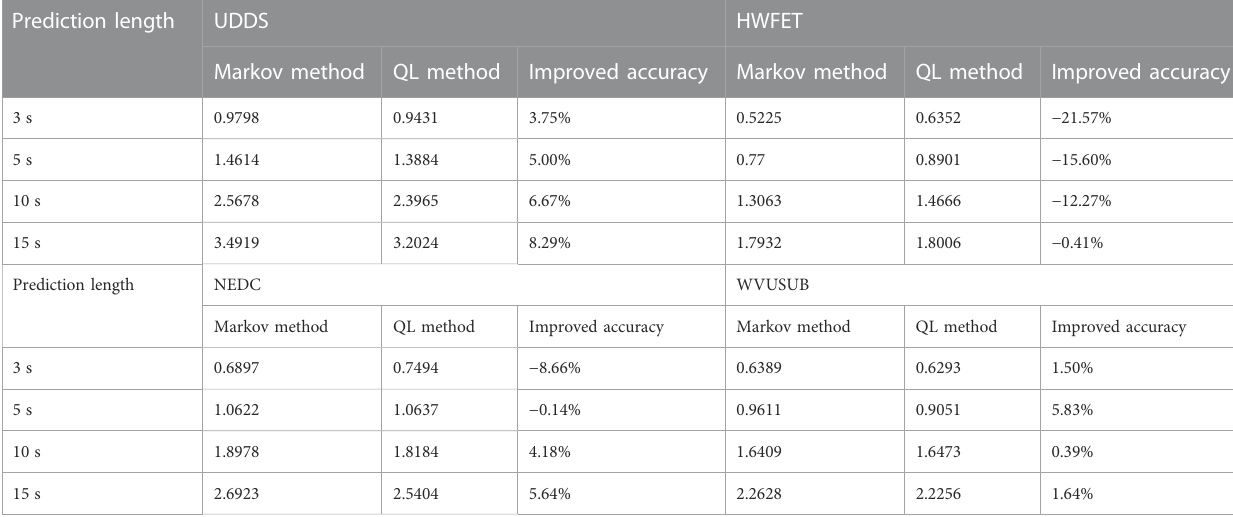
TABLE 3 Comparative analysis of speed prediction results.